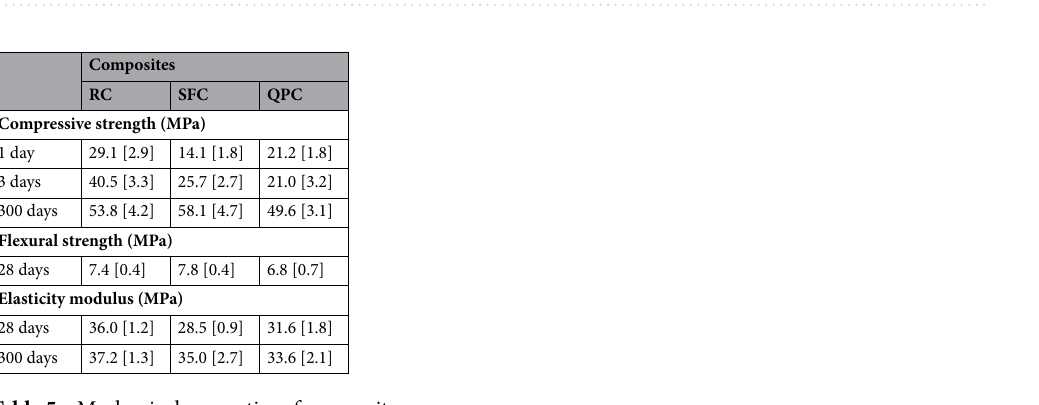
Table 5. Mechanical properties of